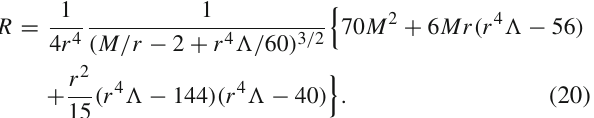
refer to S ( 2 ) × S ( 2 ) and S ( 4 ) topologies. In each of the